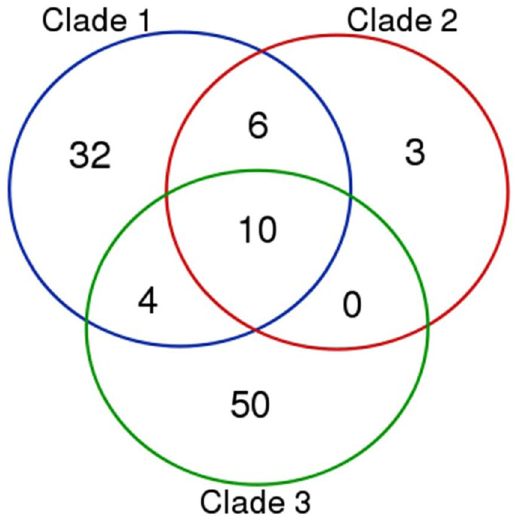
Figure 3. Venn diagram illustrating the number of orthologues shared between C . coli major clades. 10 orthologue were found in all three C . coli